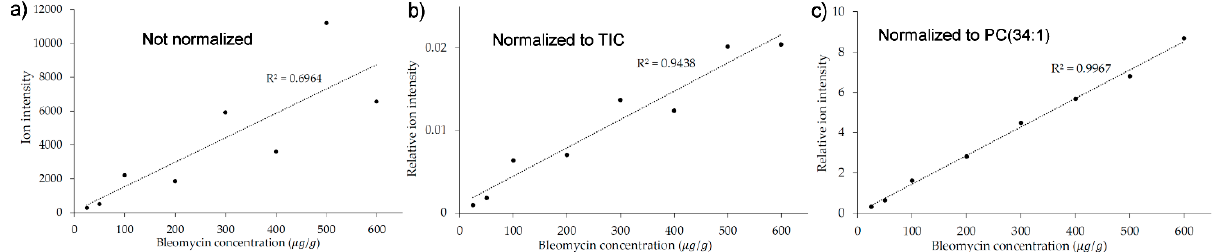
Figure 3. Standard curves generated using different types of normalization. ( a ) Non-normalized. ( b ) Normalized to TIC. ( c ) Normalized to reference peak of the endogenous lipid (PC (34:1)).